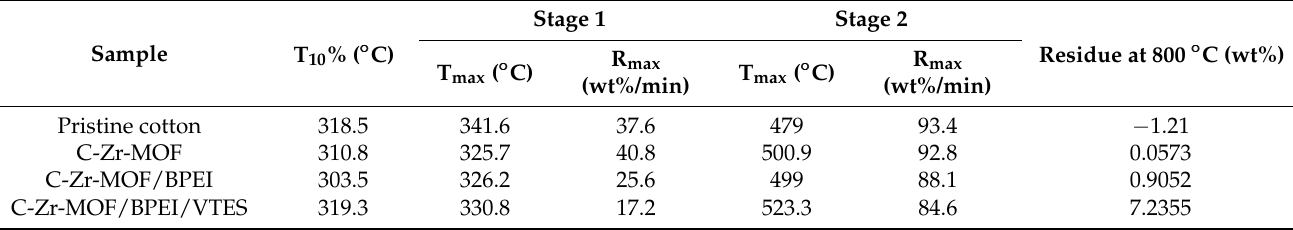
Table 1. TGA data of pristine cotton and treated samples under air